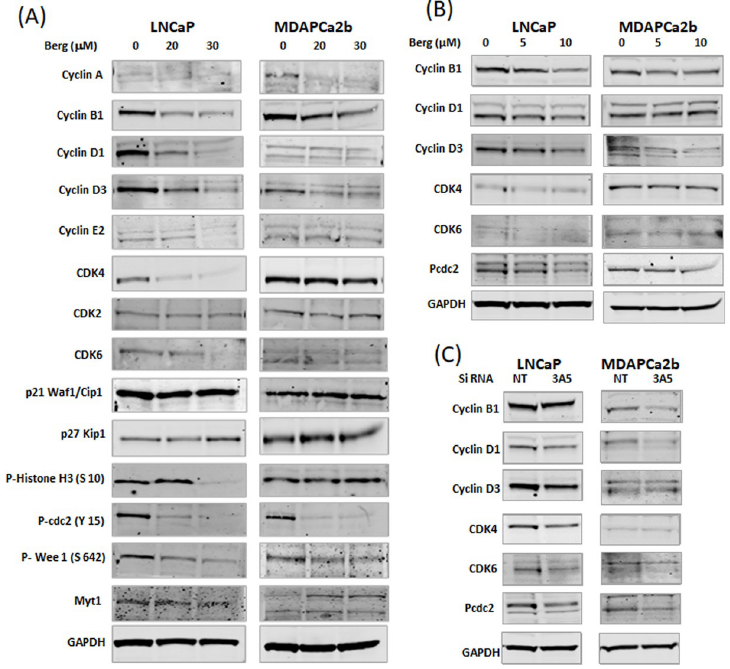
Fig 4. Differential regulation of cell cycle regulating protein after bergamottin treatment. (A &B) Western blot analysis of control and bergamottin treated cells depicting changes in cell cycle regulating proteins. Treatment was either given for 48 hrs. (high dose, 20 and 30 μ M) or 96 hrs. (low dose, 5 and 10 μ M) as described in Fig 3A and 3B. (C) the effect of CYP3A5 siRNA on cell cycle regulating proteins as compared to NT (non-target) control siRNA pool treatment (96 hours). GAPDH has been used as a loading control. The experiment was repeated three times, a representative replicate is